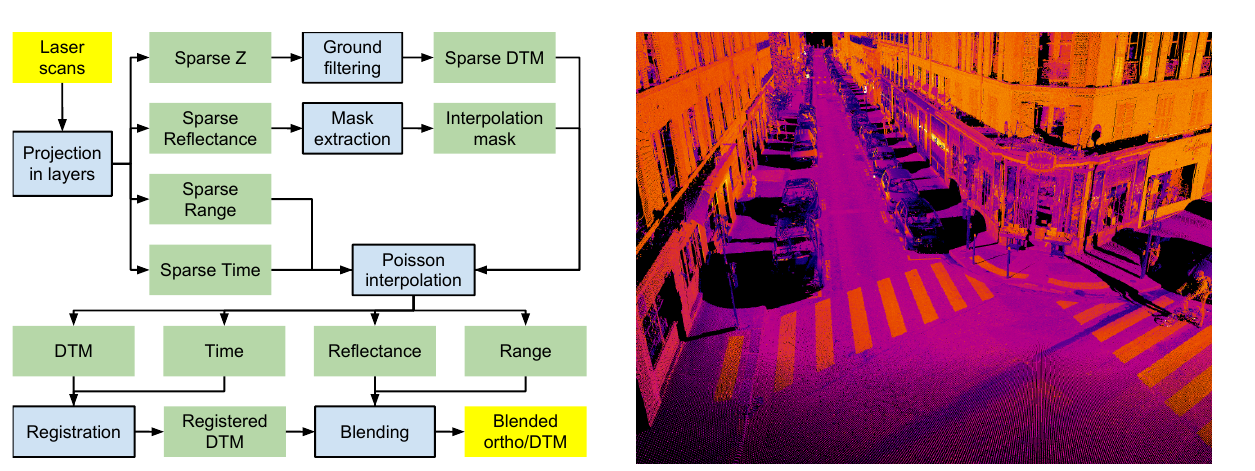
Figure 2: A view of the Mobile Laser Scan (MLS) used in this study, coloured with